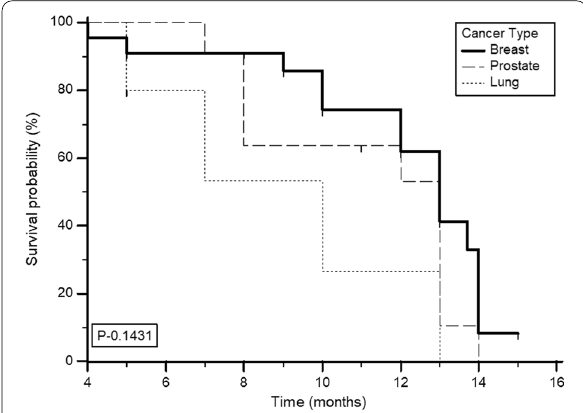
Fig. 5 Kaplan–Meier analysis: overall survival according to the type of cancer